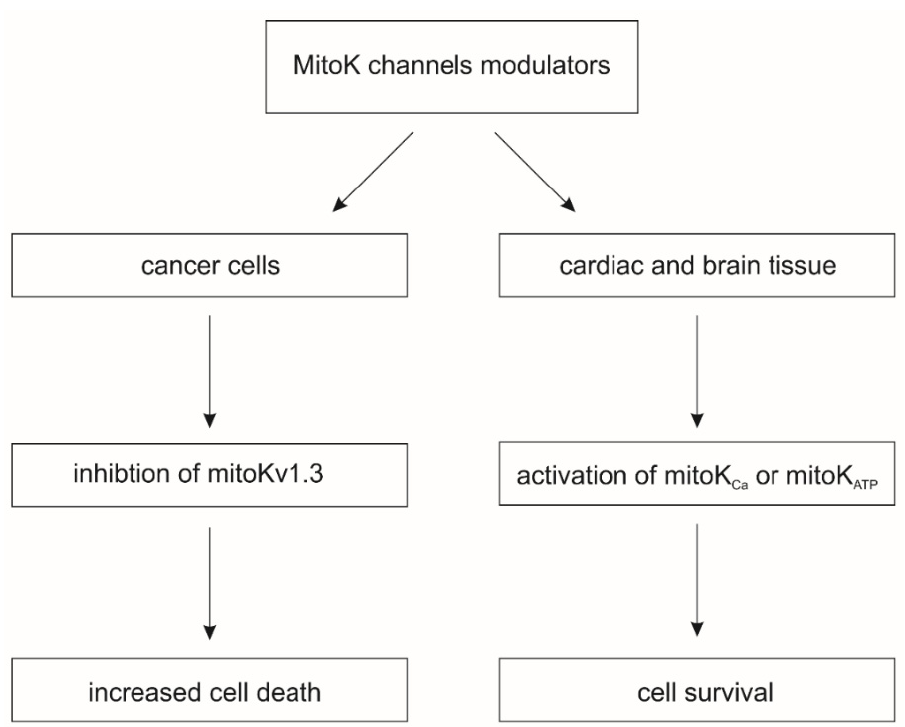
Figure 1. Diagram of the possible beneficial effects of activation or inhibition of mitoK channels with pharmacological pharmacological substances.